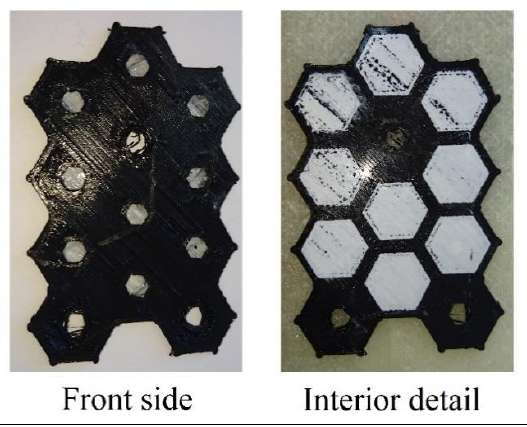
Figure 3. Generic viscoelastic layer.